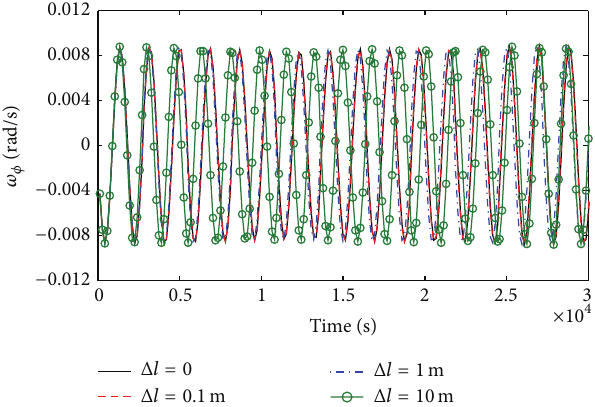
Figure 22: The time history of yaw angle 𝜙 with different Δ𝑙 , 𝜏 = 0 .